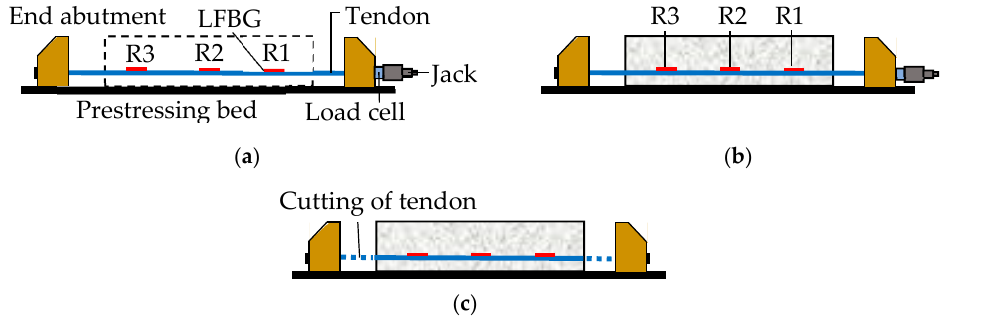
Figure 5. Three stages of pre-tensioning: ( a ) applying prestress to tendons; ( b ) casting and curing of concrete member; and ( c ) cutting of tendon.